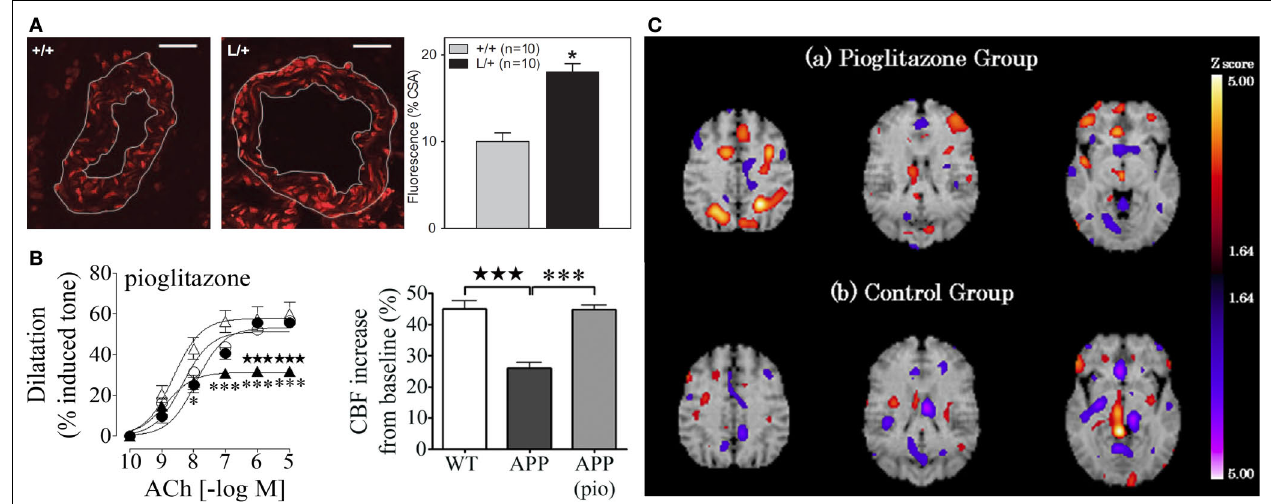
response to whisker stimulation in aged APP mice. •, wild-type (WT); (cid:123) , treated WT; (cid:83) , APP; (cid:85) , treated APP. Reproduced from Nicolakakis et al. (2008). (C) Pioglitazone restored CBF in the parietal and frontal lobes of AD patients in single photon emission computed tomography (SPECT) studies. Reproduced with generous permission from Sato et al. (2009) and